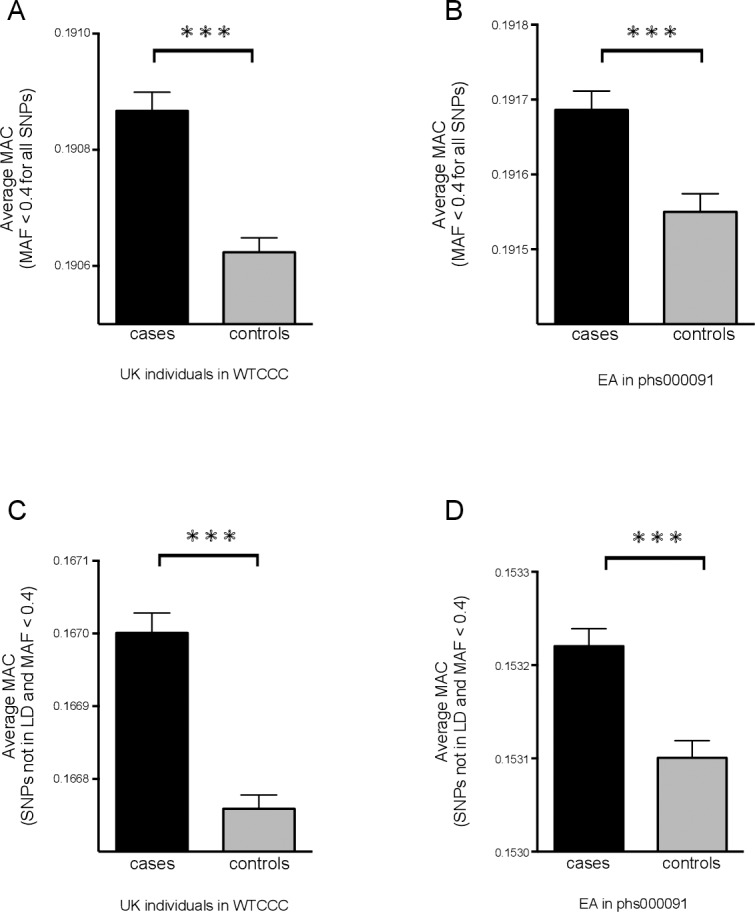
Average MAC (MAF < 0.4) values.Average MAC values of case and control group in UK individuals of European ancestry from WTCCC dataset (A and C) and EA samples from phs000091 dataset (B and D) using SNPs either before (A and B) or after LD clumping (C and D). Student’s t test was used for comparing average MAC. Symbol *** means P value < 0.001.